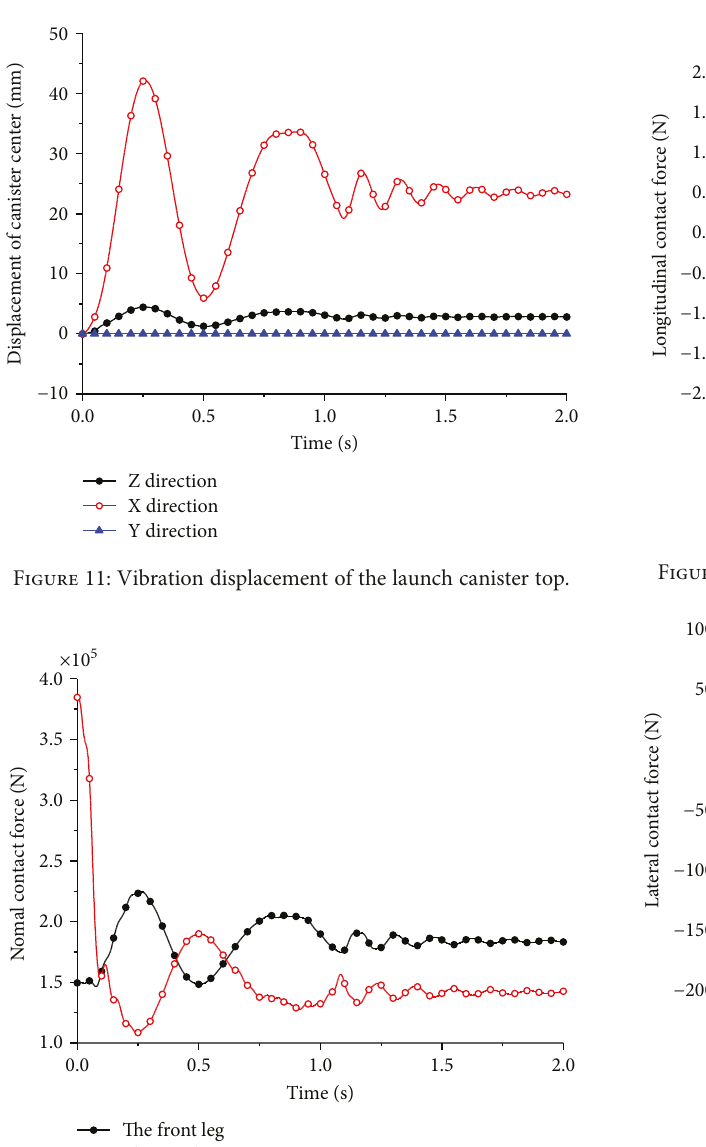
Figure 14: Contact force of legs in lateral